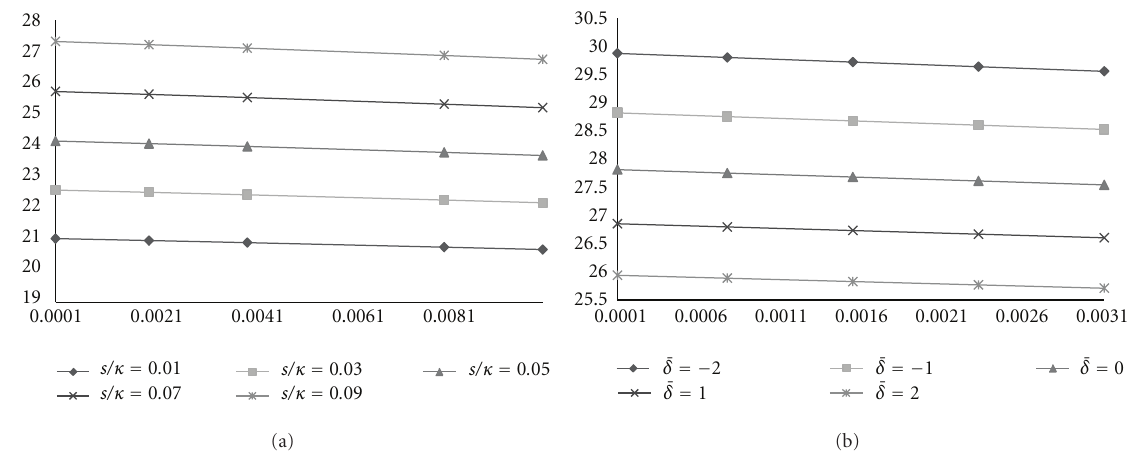
Figure 7: (a)-(b) Variation of load-carrying capacity with respect to ψ and s/κ , δ .